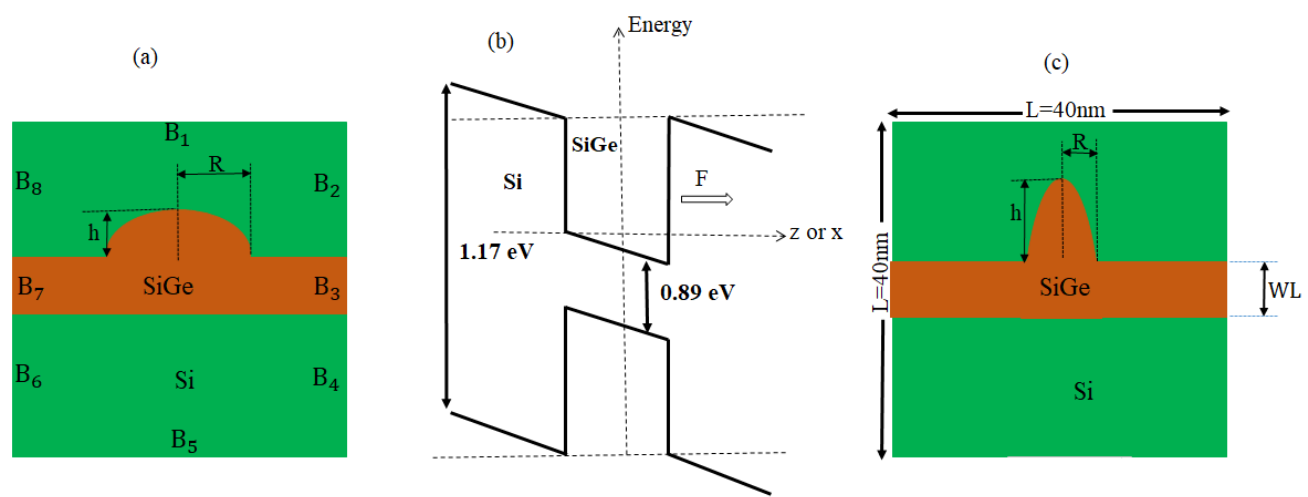
Figure 1. Cross section of oblate QD ( a ), Energy band diagram of QD ( b ), and prolate QD ( c